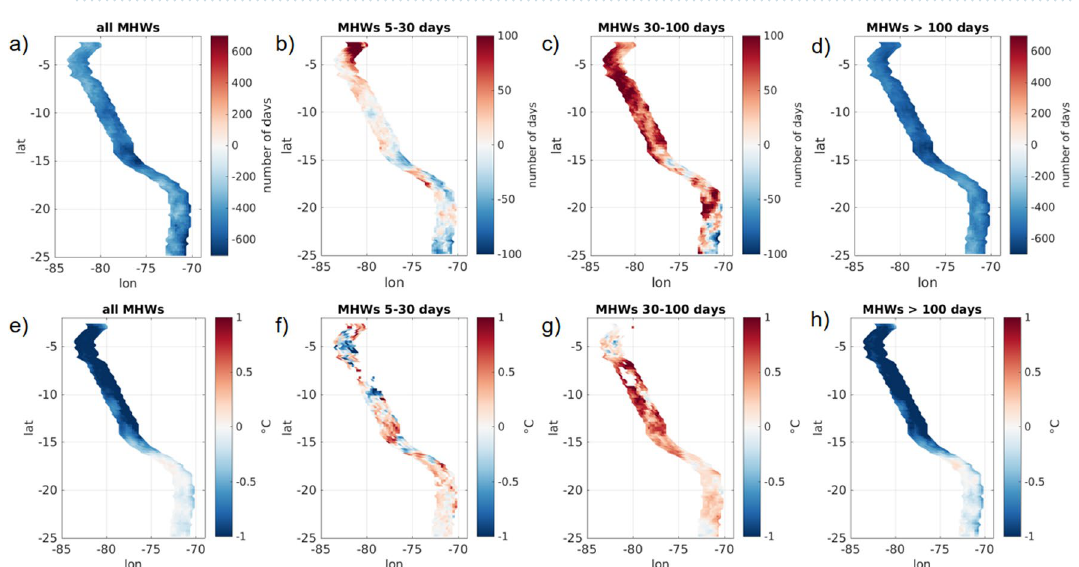
Figure 5. Differences in MHWs exposure and intensity between the period 1982–2000 and the period 2001–2019 (calculated as [2001:2019]–[1982:2000]). ( a – d ) Difference in the number of days affected on each data point and ( e – h ) difference in averaged intensity for ( a , e ) all events, events of duration ( b , f ) 5–30 days, ( c , g ) 30–100 days and ( d , h ) longer than 100 days. The figure was created using Matlab R2020b (https:// matlab. mathw orks.